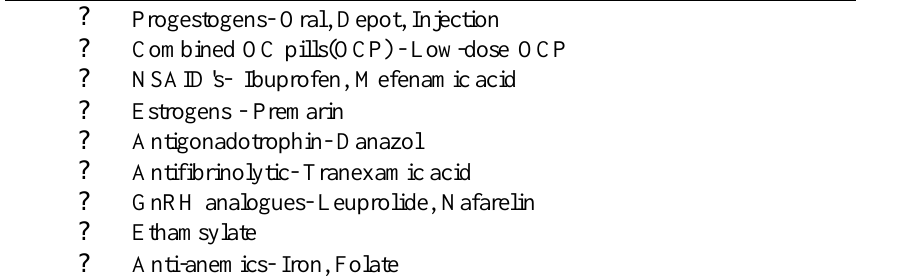
Table VII : Medical treatment options for DUB (Adapted from Speroff et al 21 ) Bleeding